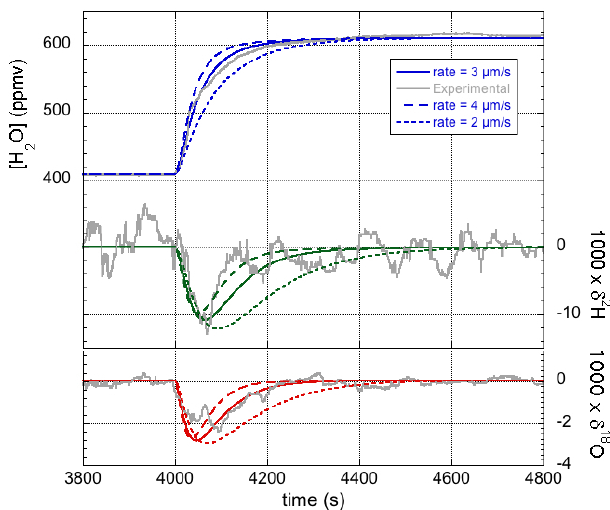
Figure 3. Experimental data (gray curves) and model simulations of the humidity (blue traces; top) and isotope response curves (green for δ 2 H and red for δ 18 O; bottom) for three different values of the evaporation rate k e . The best fit is obtained for k e ≈ 3µms − 1 , whereas a higher (lower) value results in a simulated dynamic re- sponse that is too fast (slow) compared with the measured response.